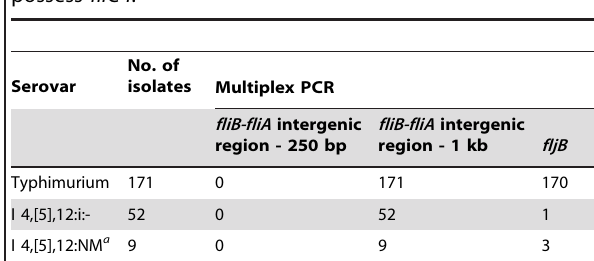
Table 4. Detection of Salmonella Typhimurium, I 4,[5],12:i:- and I 4,[5],12:NM by PCR among 232 Group B Salmonella that possess fliC-i .